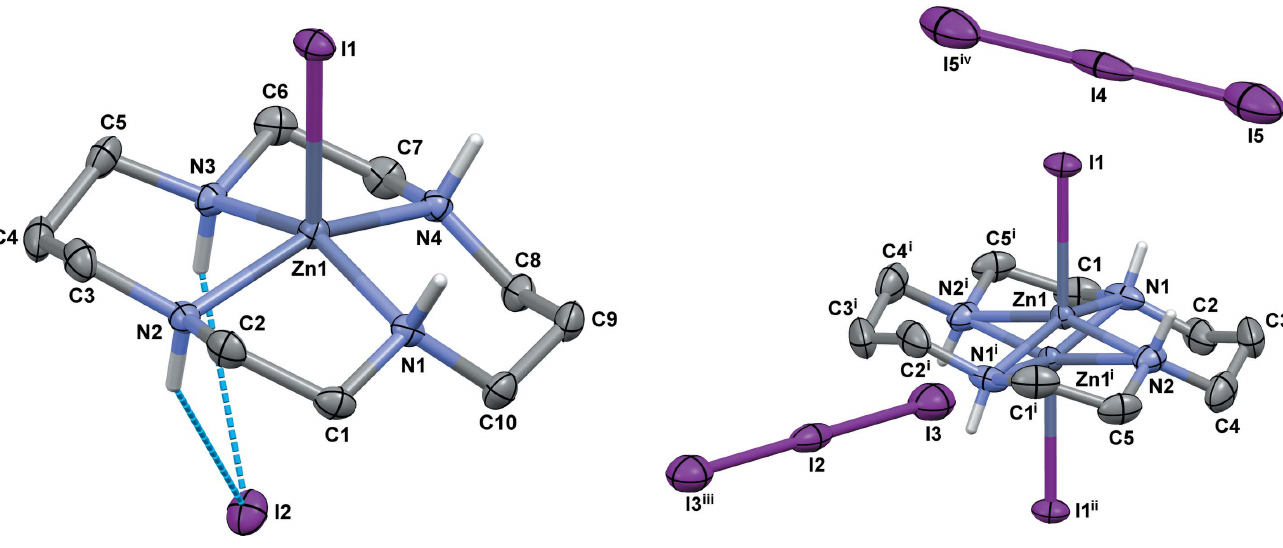
, (cid:3) y + 3 , (cid:3) z + 1 ; 2 2 2